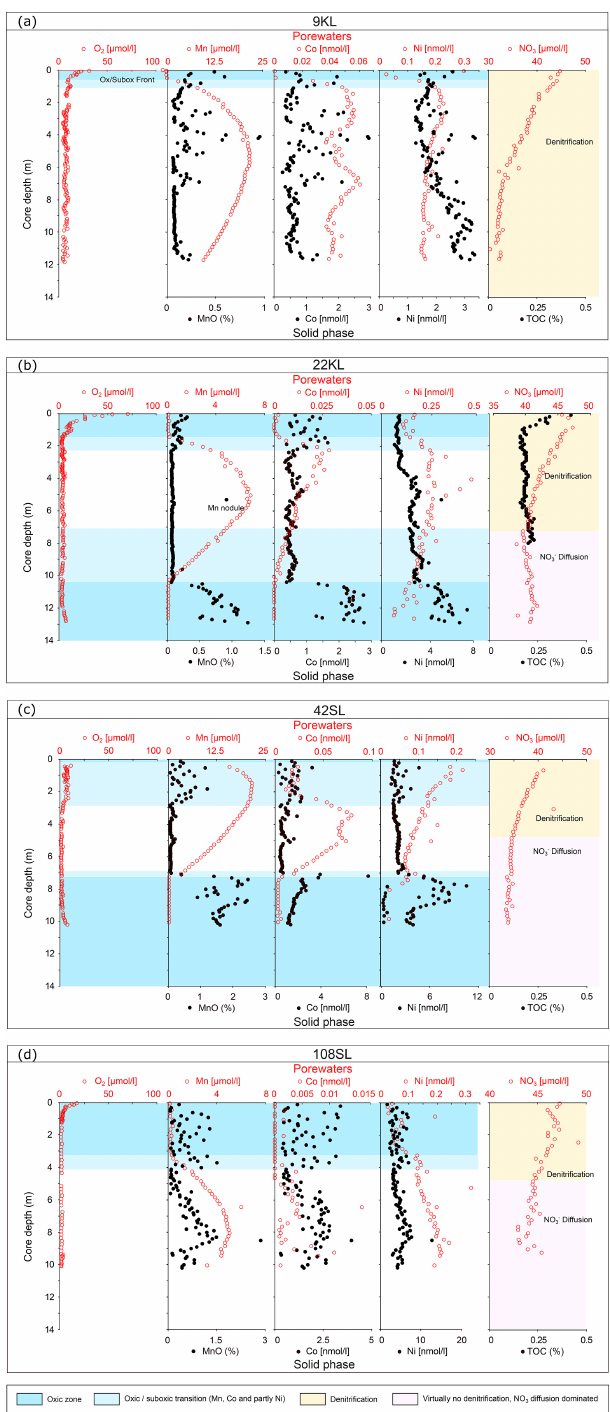
Figure 4. (a–d) Combined porewater and solid-phase profiles for oxygen, Mn, Co, Ni and nitrate in the cores with suboxic